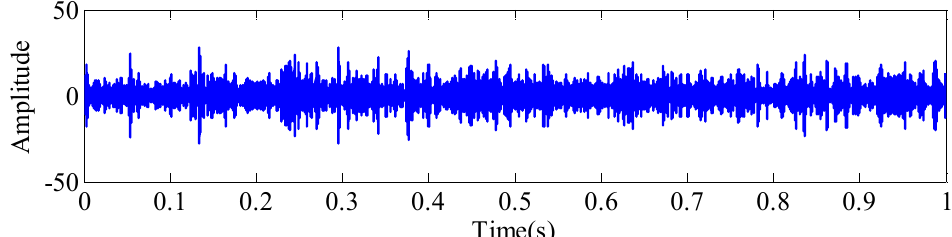
Figure 24. Noise reduction diagram of the manually selected signal segment.